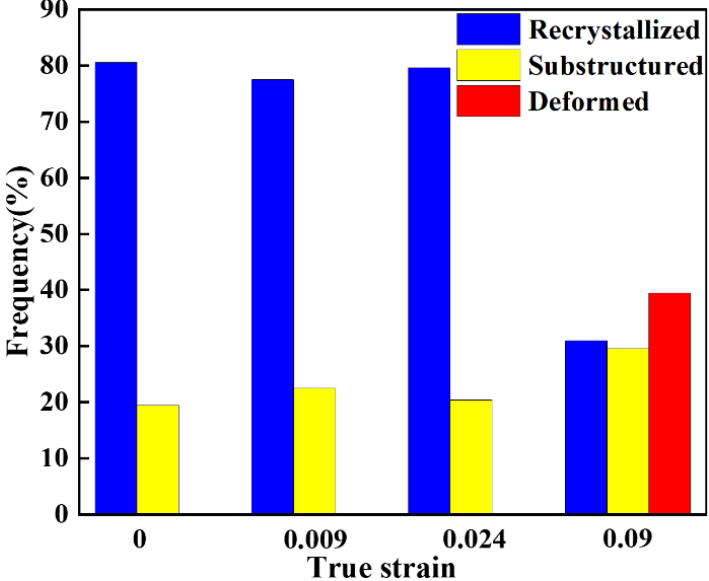
Figure 9. The evolution of grains at different true strains.